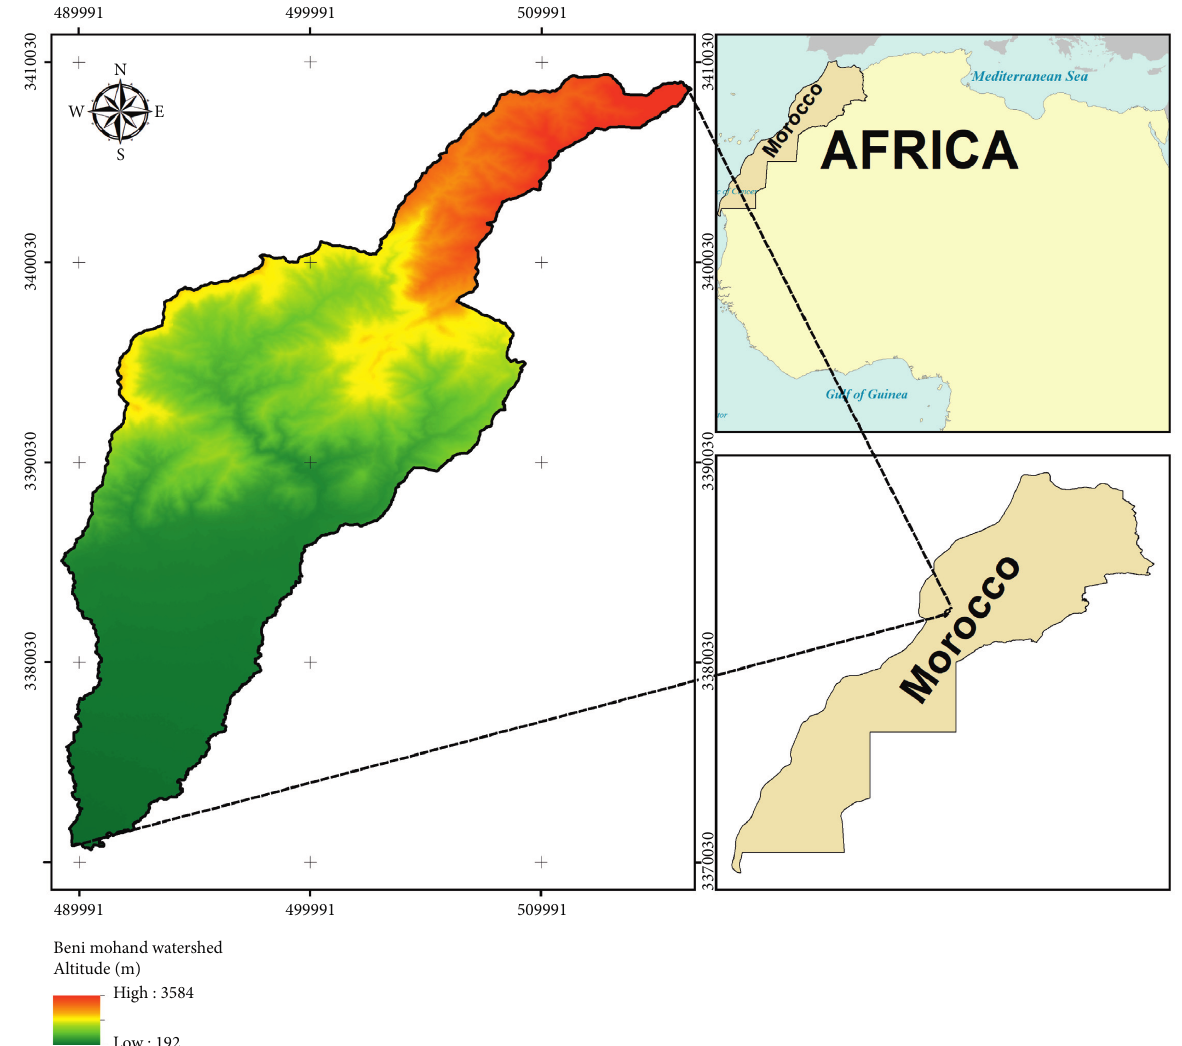
Figure 1: Location of Beni Mohand watershed, Western High Atlas,